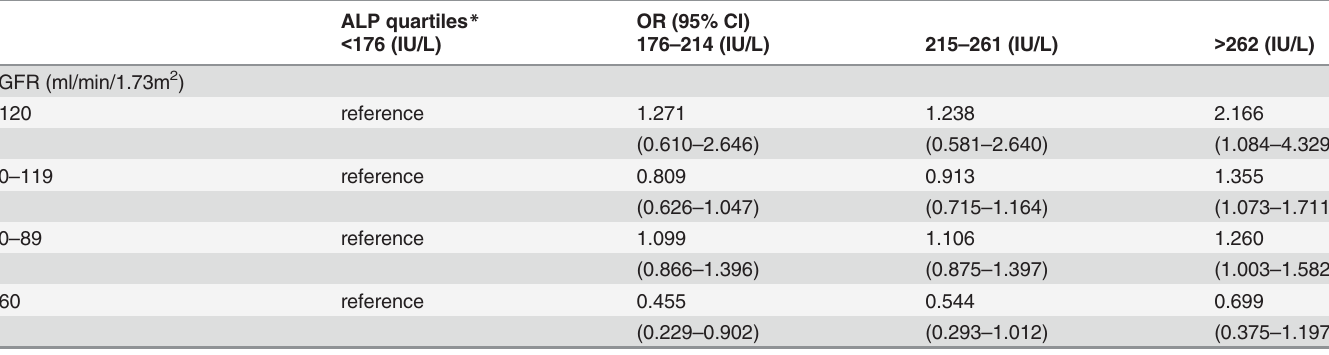
Table 3. Associations between serum alkaline phosphatase quartiles and diabetes according to the estimated glomerular filtration rate